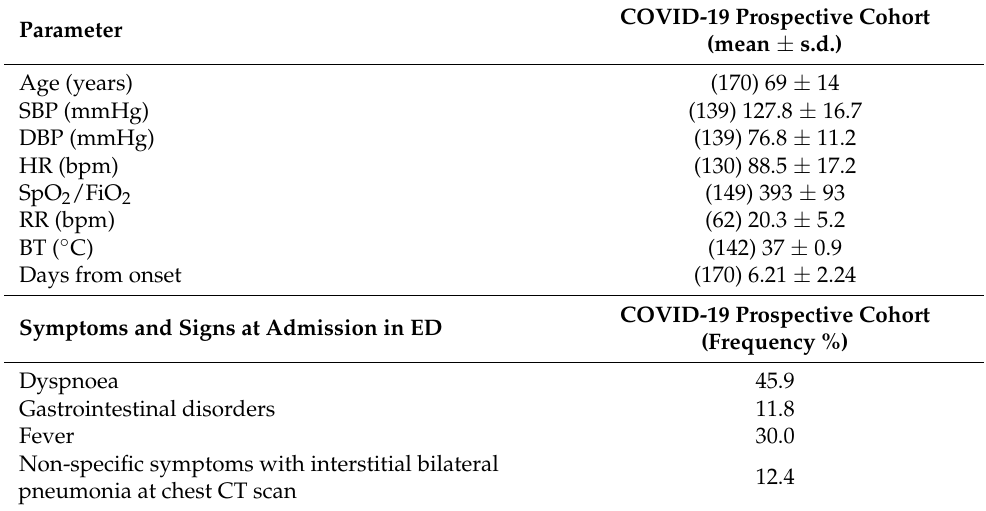
Table 2. Physiological variables and symptoms and signs of admission of COVID-19 prospective cohort. Parameter